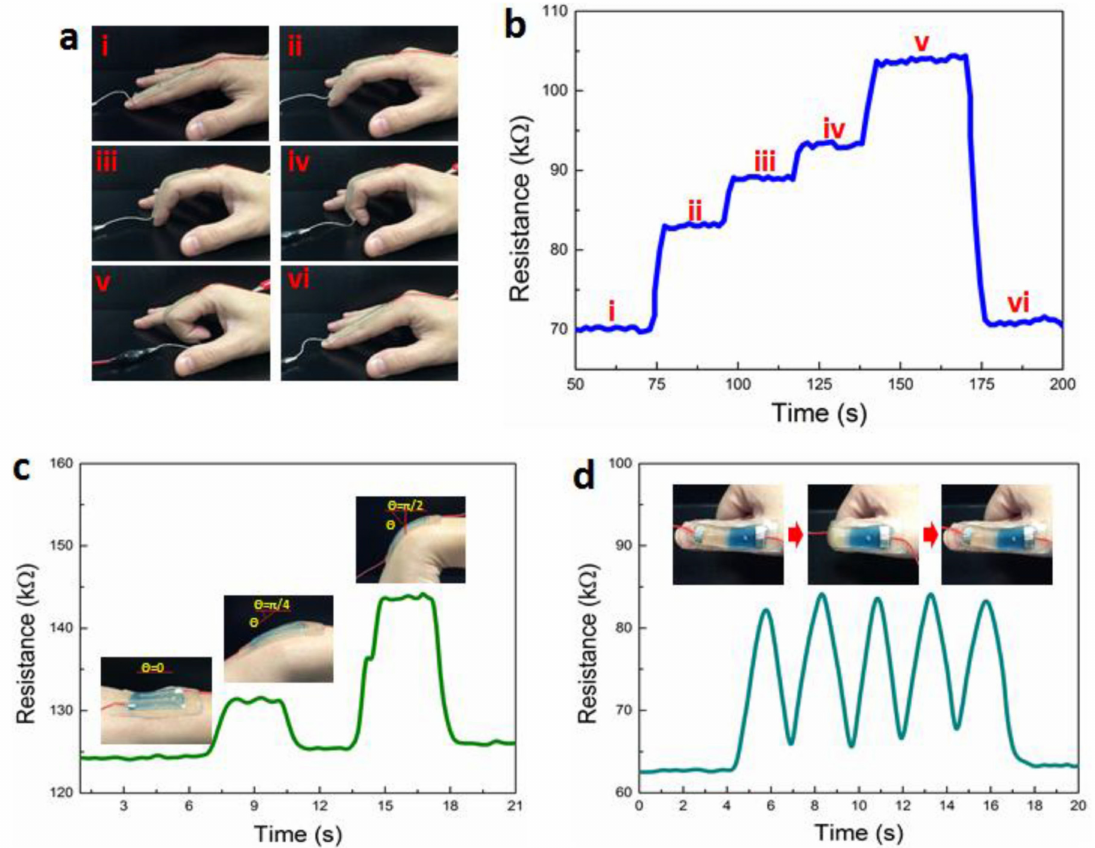
Figure 15. Real-time monitoring of numerous human motions ( a ), ( a ) the κ -carrageenan/PAAm DN hydrogel-based strain sensor fixed on forefinger to monitor its bending, and ( b ) changes in resistance as a function of time. ( c ) Change of resistance with time when the 3D printed DN hydrogel sample with the shape of number “S” was used as a conductor. The insets show the 3D printed DN hydrogel-based strain sensor attached to the wrist at different bending radians, 0, π /4, and π /2, respectively. ( d ) Change of resistance with time when the self-healed DN hydrogel was used as a conductor, and the insets show that the self-healed DN hydrogel-based strain sensors attached on the thumb finger bending repeatedly. Copyright 2017 ACS. Reprinted with permission from ref. [325].